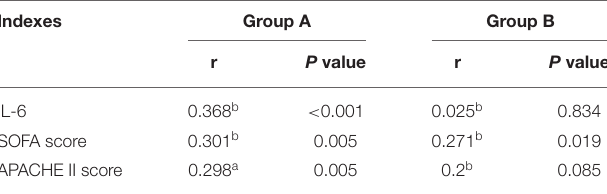
TABLE 4 | Correlation results of D-lactic acid with IL-6, SOFA score and APACHE II